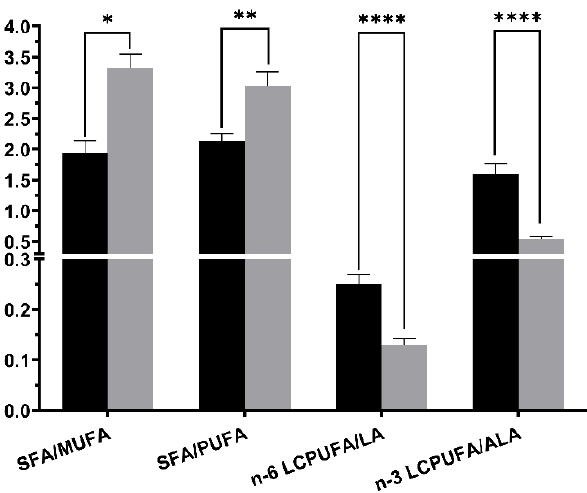
Figure 3. Main fatty acid ratios changes between colostrum (black bar) and human donor milk (grey bar). Asterisks indicate significant differences (* p < 0.05; ** p < 0.01; **** p < 0.0001) in each group among sampling points (SFA: saturated fatty acids; MUFA: monounsaturated fatty acids; PUFA: polyunsaturated fatty acids; n-6 LPUFA: n-6 long chain polyunsaturated fatty acids; LA: linoleic acid; n-3 LCPUFA: n-3 long chain polyunsaturated fatty acids; ALA: α-linoleic acid).